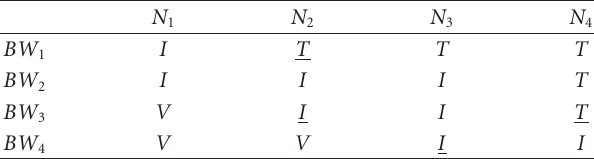
refinement for R 1 p